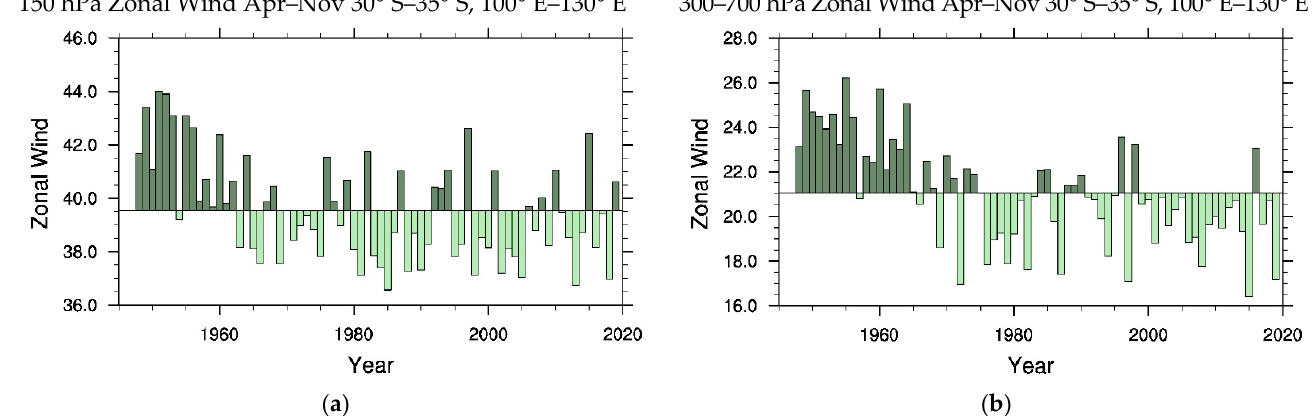
Figure 4. Vertical cross-section of April–November zonal wind (m s − 1 ) averaged between 100° E– 130° E as a function of latitude and pressure (p in hPa) for (1975–1994) minus (1949–1968). Contour intervals are 1 ms − 1 and confidence levels 𝐶 (cid:3013) > 95% where the magnitude of the plotted differences ≥ 2 ms (cid:2879)(cid:2869) .